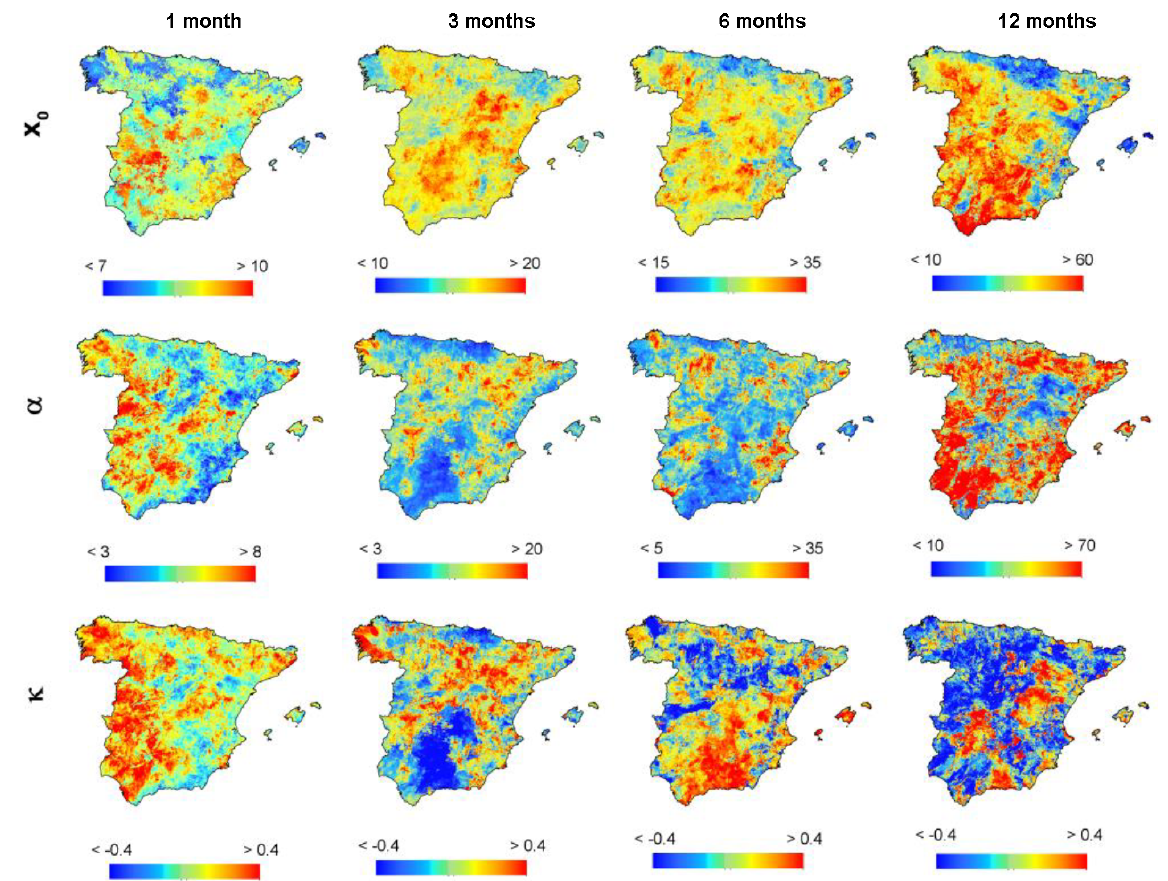
Figure 7. Spatial distribution of the parameters of the GP distribution calculated for the SPI duration